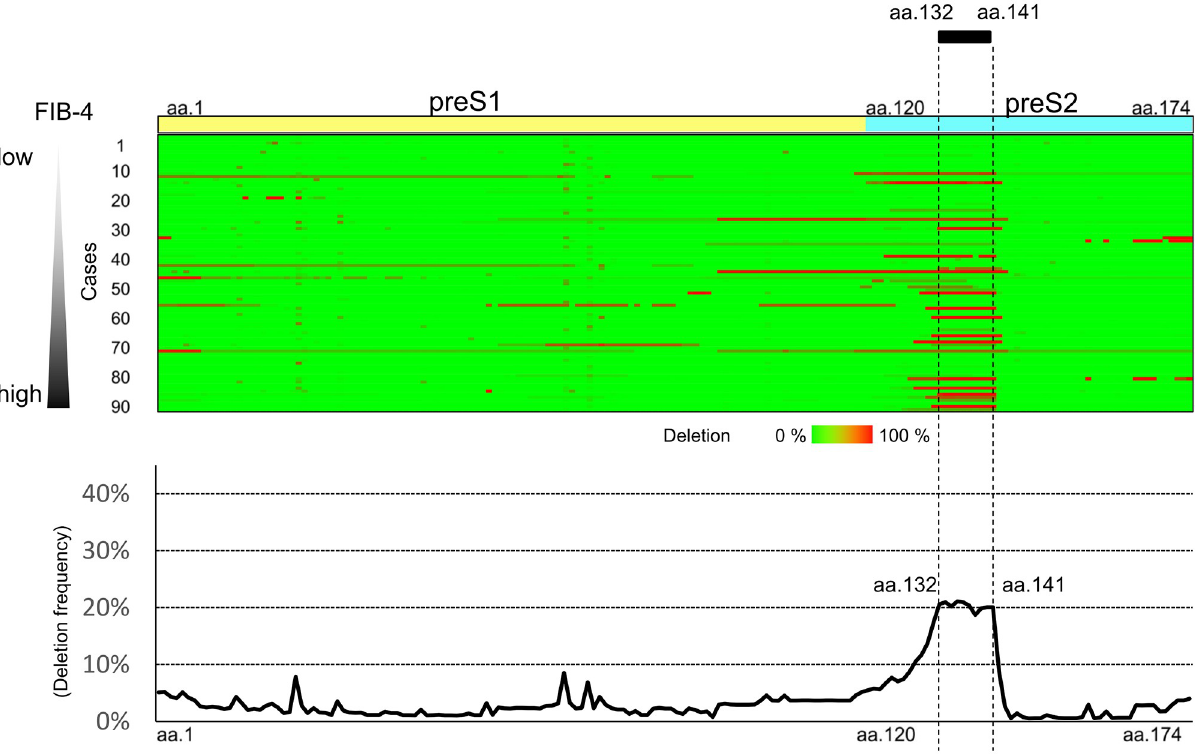
Fig 1. HBV preS deletion mapping using deep sequencing. Deep sequencing of the region of the HBV genome encoding the 174 preS amino acids was carried out and the deleted amino acids were mapped in all 90 patients. Upper panel, the frequency of deletion of each amino acid position in the preS region is expressed for each patient as a color gradient between green and red. In this figure, these sequences are arranged in the order of the FIB-4 values. Lower panel, the average deletion frequency of the preS region per patient is